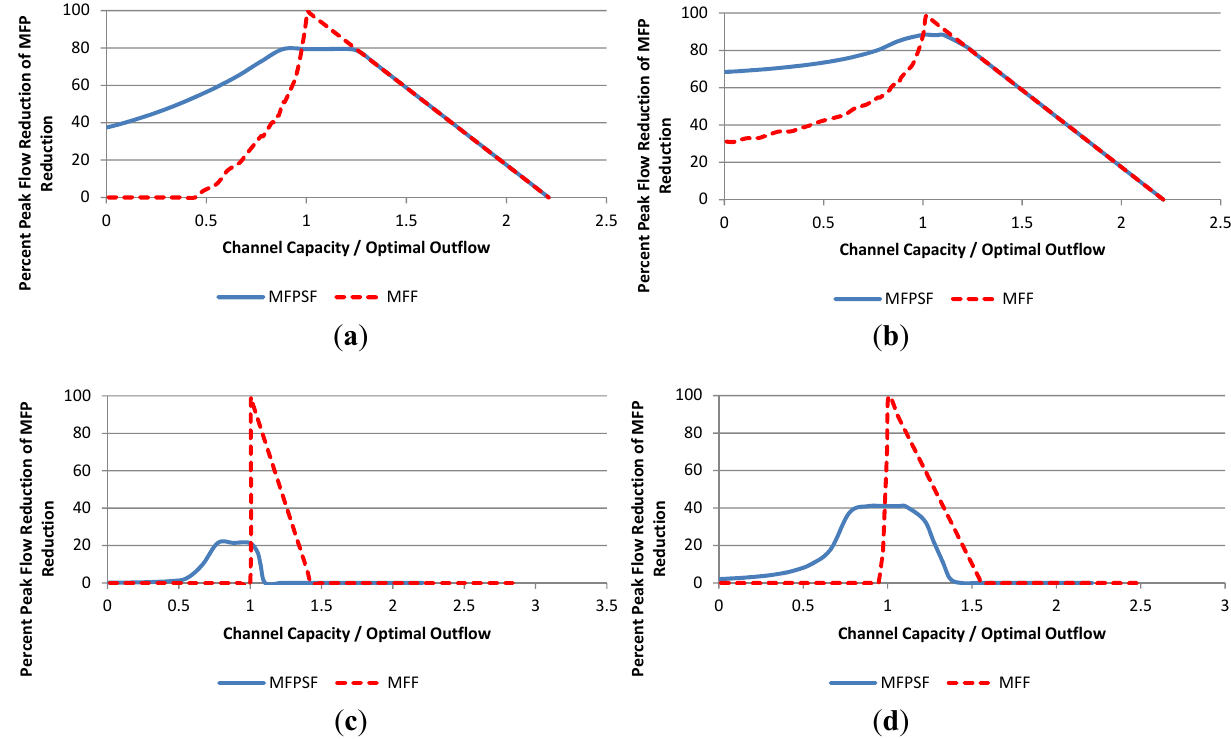
Figure 13. Peak inflow vs . peak outflow for ( a ) Triangular hydrograph and ( b ) Abrupt wave hydrograph ( c ) Flood pulse hydrograph and ( d ) Broad peak